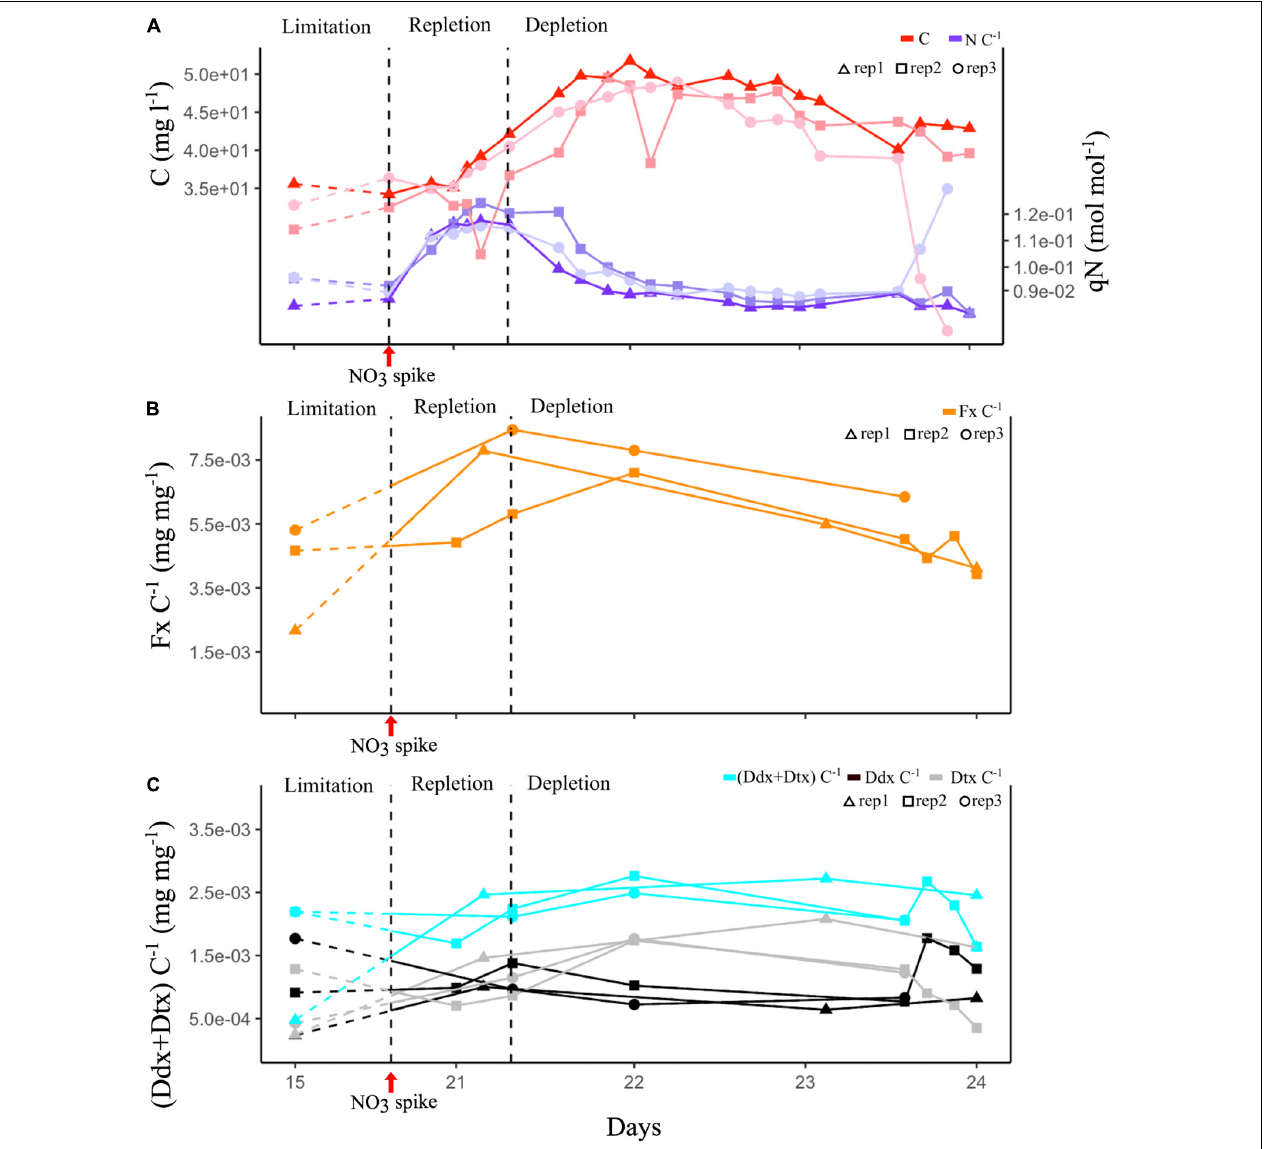
FIGURE 4 | Constant light (CL) experiment. Dashed curve corresponds to the first 5 days of culture under N limitation conditions. (A) Evolution of cell biomass expressed as total intracellular C and of qN expressed as intracellular N:C ratio of three culture replicates. (B) Evolution of the Fx:C ratio of three culture replicates. (C) Evolution of the photoprotective pigment ratios: (Ddx + Dtx):C, Ddx:C, and Dtx:C of the three culture replicates. Vertical black dashed lines mark the transition between limitation and repletion, and repletion and depletion in